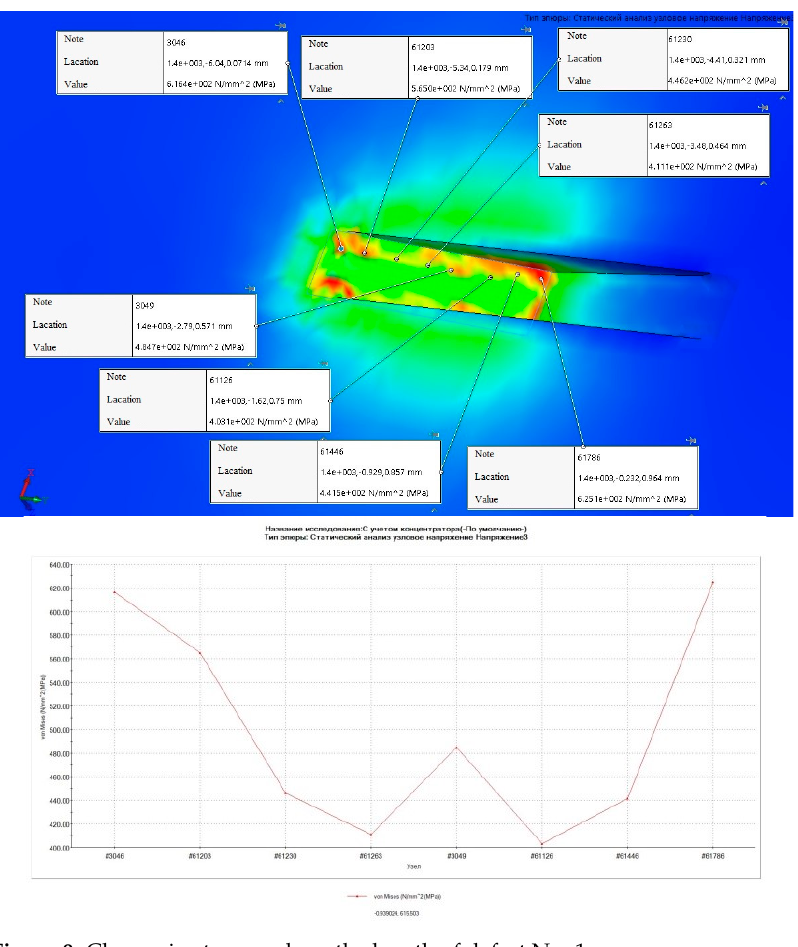
Figure 9. Change in stresses along the length of defect No. 1.